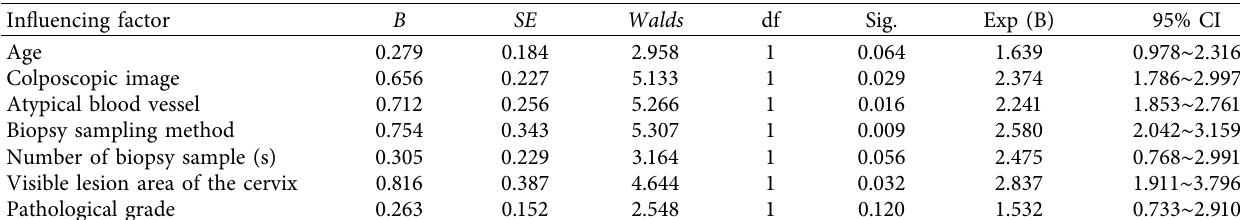
Table 3: Multivariate analysis of influencing factors on detection of CIN and ICC in the colposcopic biopsy. Influencing factor B